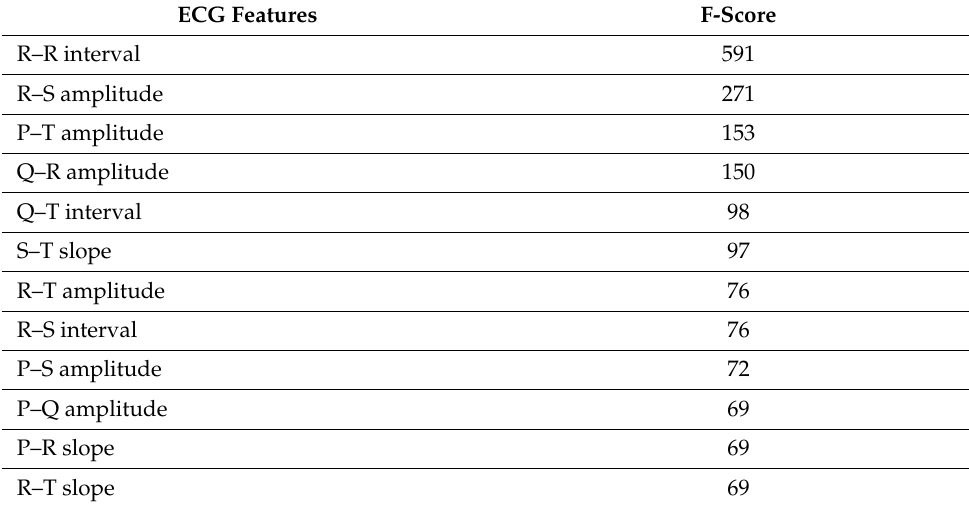
Table 4. Feature importance of Oc-SVM model in predicting dysglycemia.